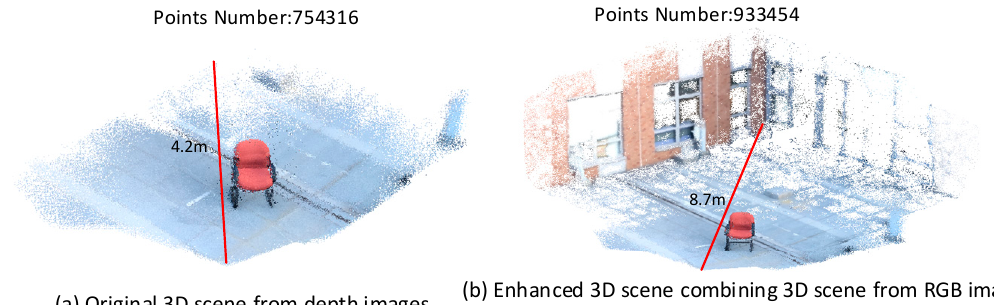
Figure 10. Results of geometric registration for chair model.